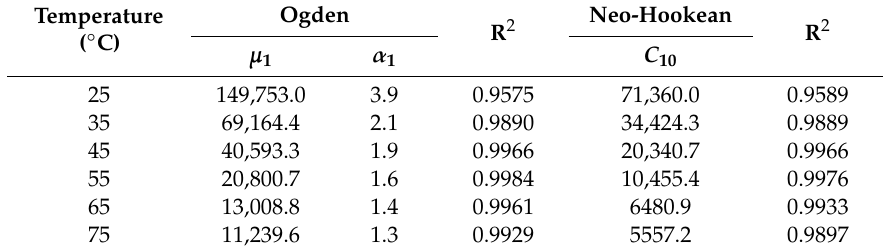
Table 2. The model parameters (see Section 2.5) of 1st order Ogden and Neo-Hookean strain energy function.